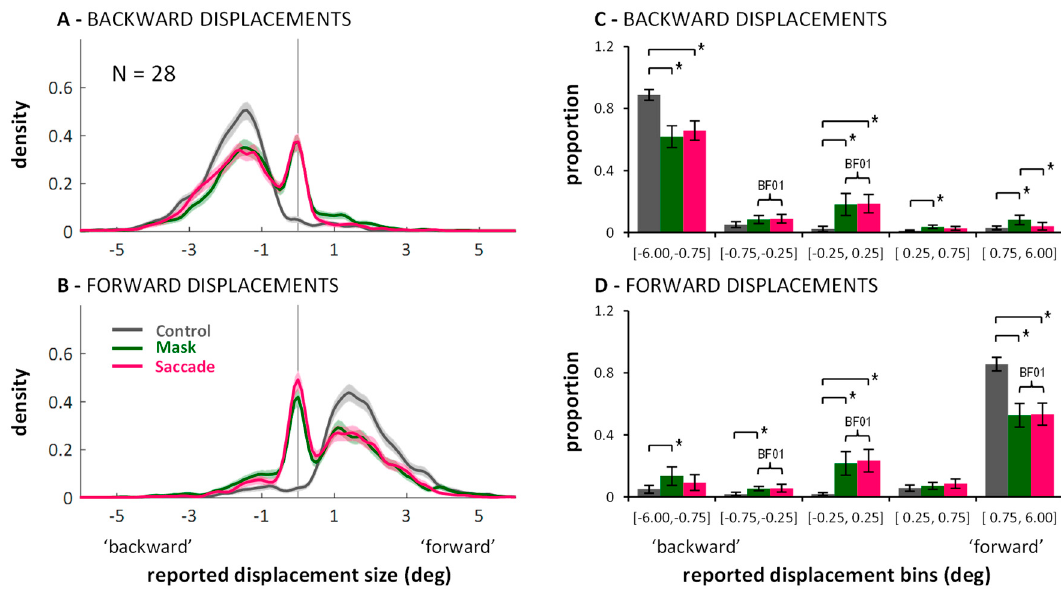
Figure 3. Distribution of responses in the three conditions (color-coded) of Experiment 1: Kernel density functions showing data combined across participants (panels ( A , B ); shadings represent bootstrapped 95% confidence intervals), and proportion of responses falling into the specified bins showing data averaged across participants (panels ( C , D ); error bars represent between-subjects 95% confidence intervals). Brackets marked with * illustrate significant differences in post-hoc within-subjects paired t-tests, p < 0.0017). Curly braces marked with BF01 illustrate Bayes factors in favor of H0, BF 01 > 3.00. Data are shown separately for backward (upper row) and forward (lower row) displacements.